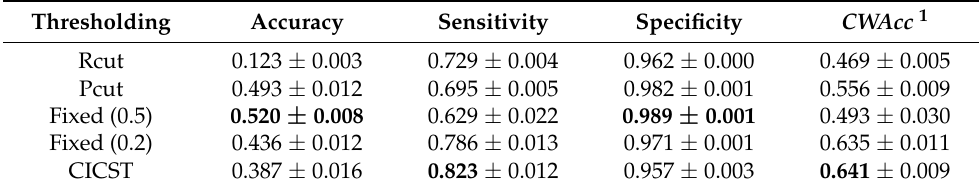
Table 2. The metric scores (mean ± std) achieved by different thresholding methods in 5-fold cross-validations.